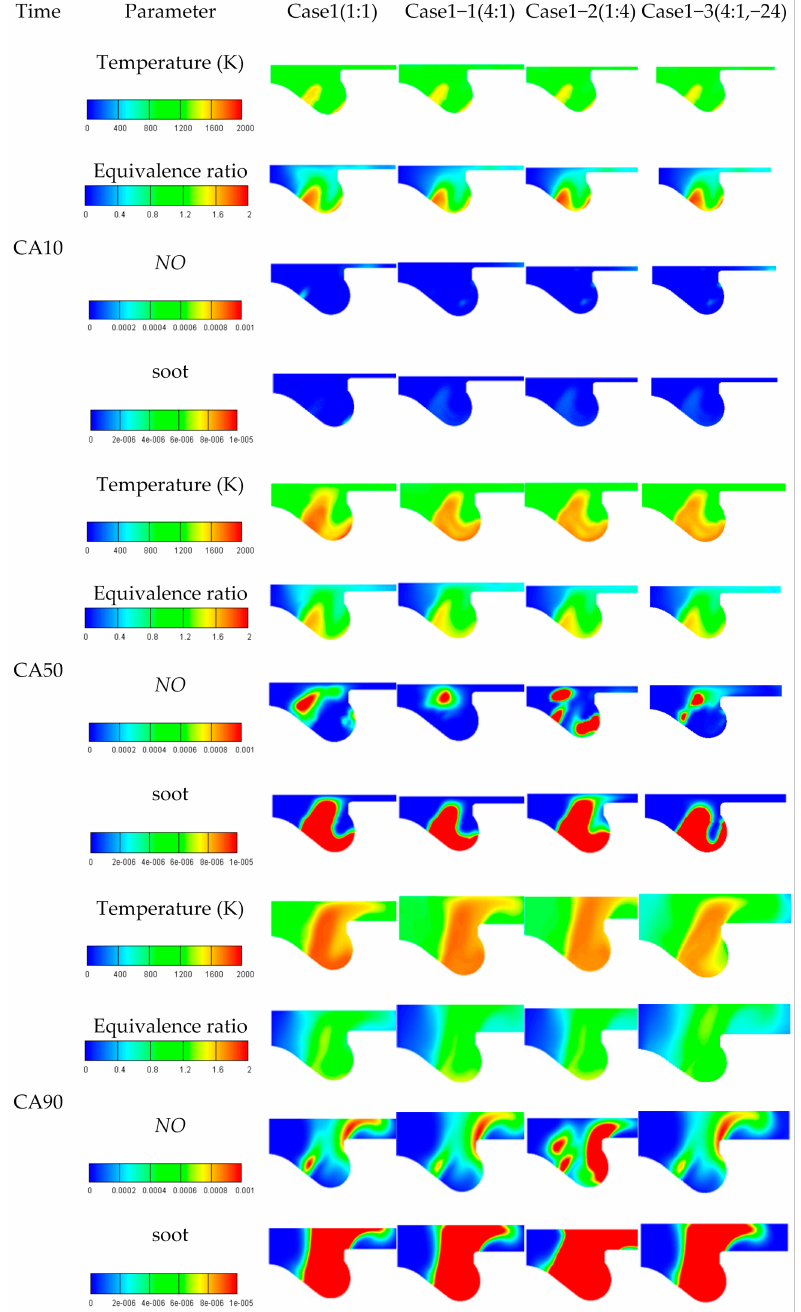
Figure 10. Temperature, fuel-air equivalence ratio, NO , and soot graphs for diverse pilot injection ratio